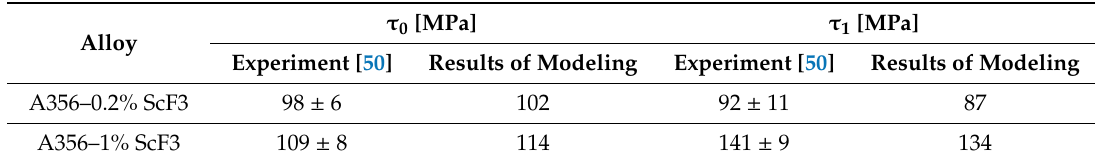
Table 2. Properties of A356-based composites containing scandium fluoride particles.